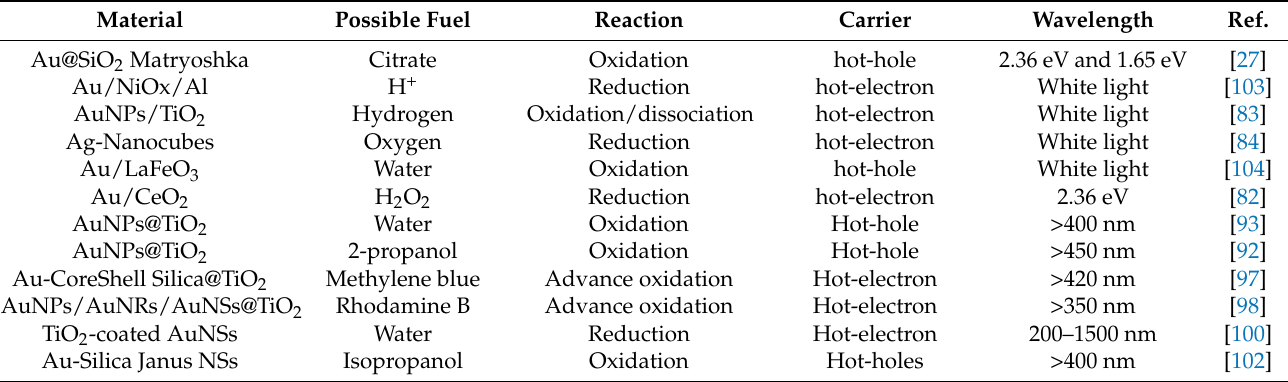
Table 1. Fuels for propelling micro/nano